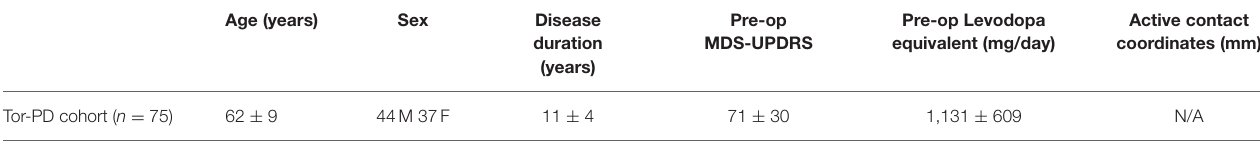
TABLE 1 | Demographic information of pre-DBS PD patients included in the Tor-PD connectome. Age (years) Sex Disease